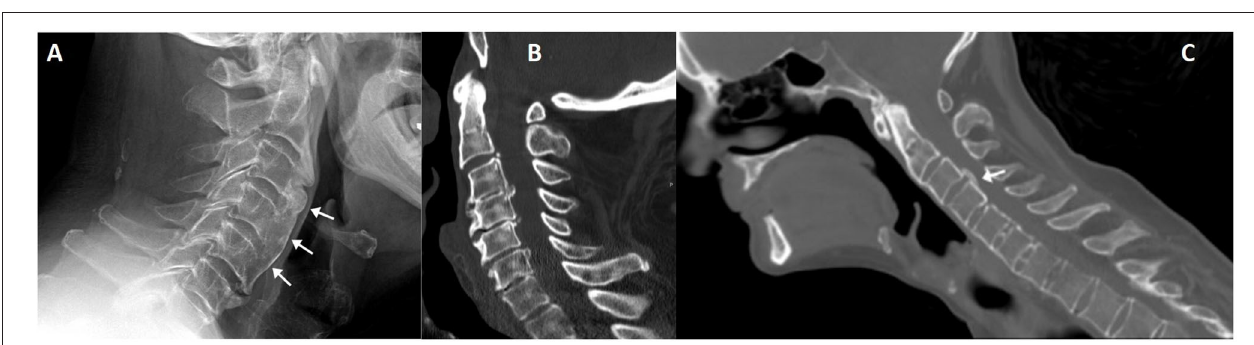
FIGURE 7 | Lateral cervical radiography of a patient with cervical undulating anterior longitudinal ligament ossification (arrows), compatible with DISH (A) . Another patient (B) with cervical DISH and ossification of the posterior longitudinal ligament; differential diagnosis with posterior syndesmophytes is not always straightforward, as seen in a CT sagittal reconstruction of a patient with ankylosing spondylitis [ (C) , arrow].